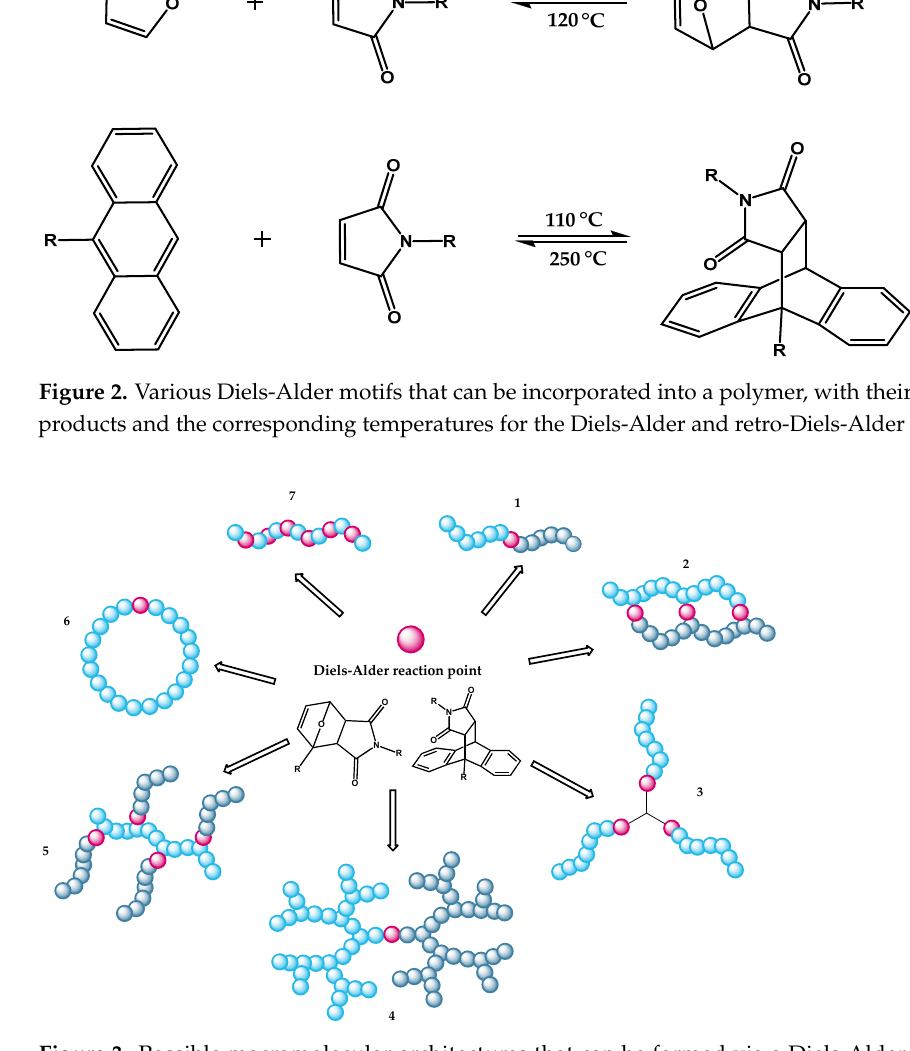
Figure 2. Various Diels-Alder motifs that can be incorporated into a polymer, with their respective products and the corresponding temperatures for the Diels-Alder and retro-Diels-Alder reaction.